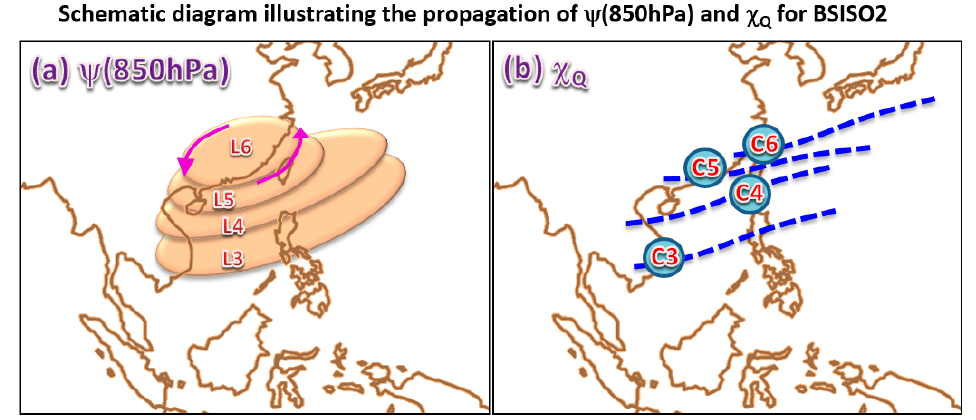
Figure 10. Schematic diagram illustrating ( a ) the propagation of the cyclonic circulation (“L” denotes the low system, number denotes the phase of related BSISO2), and ( b ) the propagation of moisture convergence line (“C” denotes the convergence, number denotes the phase of related BSISO2, circle denotes the convergence center of χ Q in Figure 6 that are important to facilitate the heavy rainfall formation in Taiwan during the 2014–2017 Meiyu seasons.